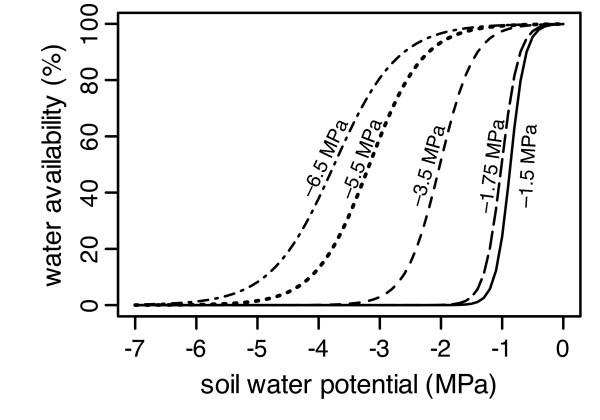
Relative water availability as a function of soil water potential. The figure shows curves for different artificial species with representative permanent wilting points of -6.5, -5.5, -3.5, -1.75, and -1.5 MPa.